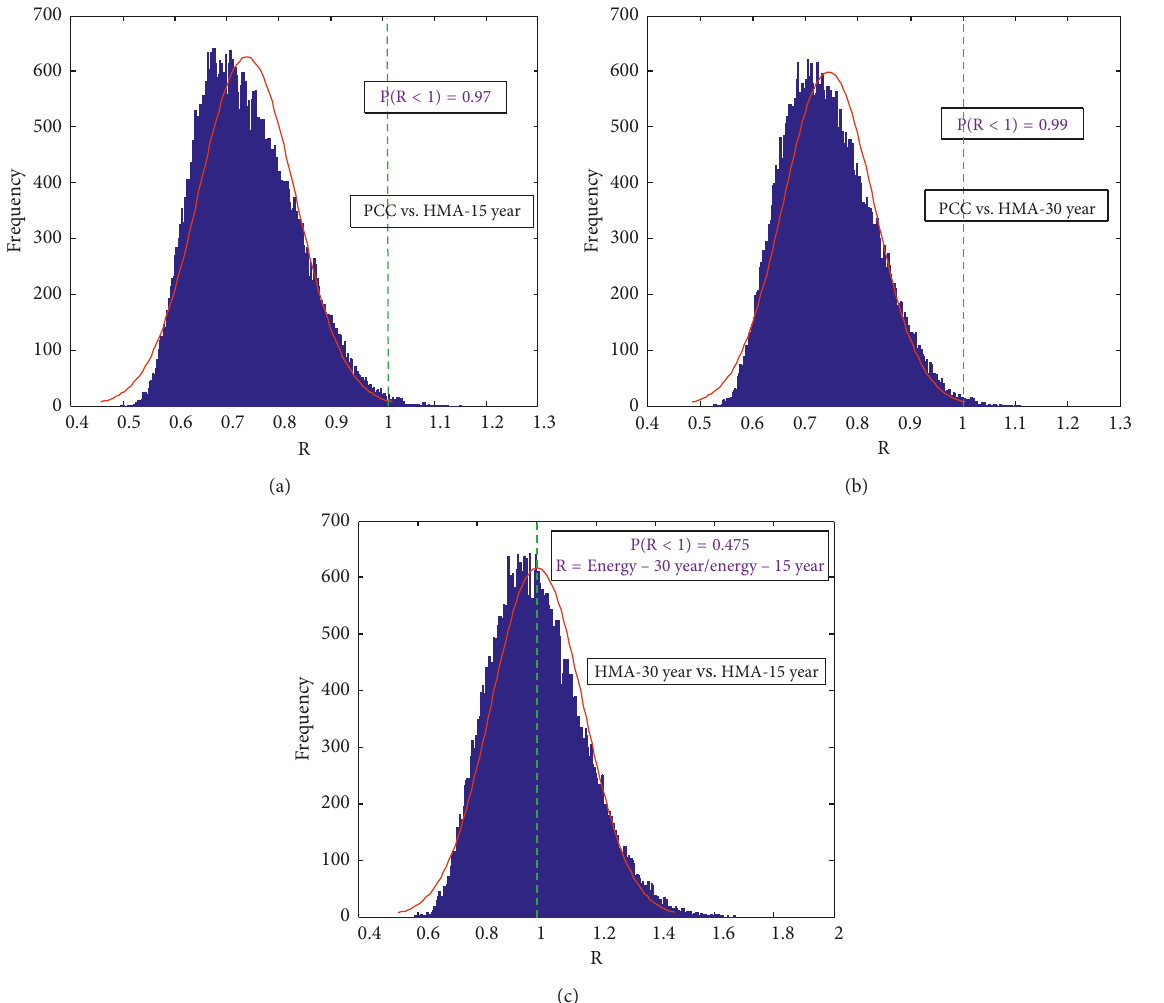
Figure 4: Energy consumption ratio probability distribution of the three pavement